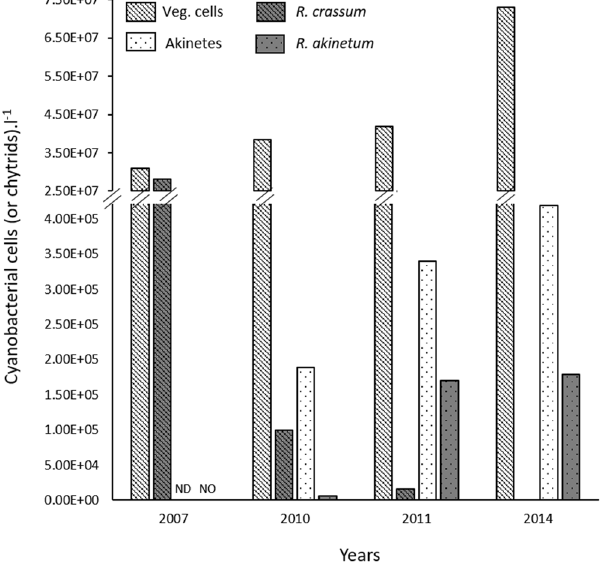
Figure 4. Overview of D. macrosporum abundances and its associated chytrids over 7 years. Maximum abundances of Dolichospermum macrosporum vegetative cells (veg. cells; hatched white bars) and akinetes (dotted white bars); and of their respective associated parasites, Rhizosiphon crassum (hatched grey bars) and R. akinetum (dotted grey bars), recorded in 2007, 2010, 2011 and 2014 in Lake Aydat at the Central station. ND: Not Determined; NO: Not